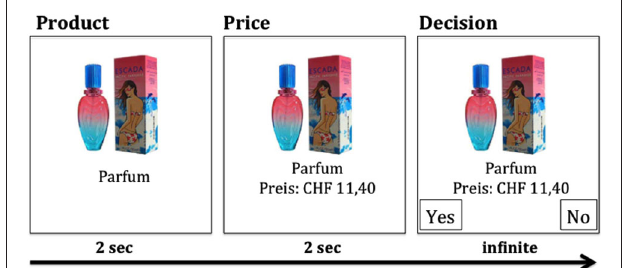
FIGURE 1 | Each product (total of 120 products) was first presented for 2 s without price information . After 2 s, the price information was added, followed by the decision option (CHF, Swiss